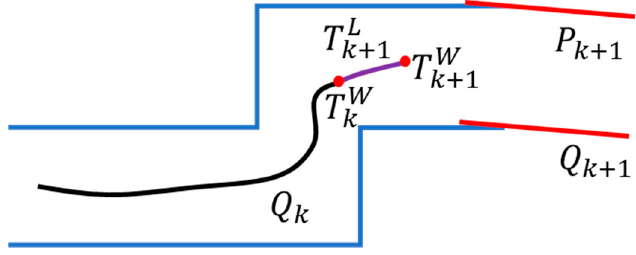
Figure 7. Point cloud map construction diagram.